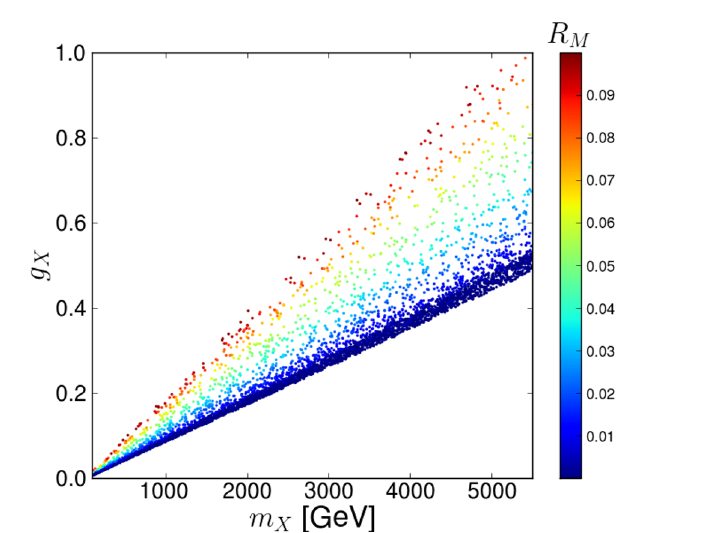
Figure 2 . The parameter points which realize relic density of DM as 0 . 11 ≤ Ω h 2 ≤ 0 . 13 ; we fix χ = 10 − 3 here. The color gradient indicates the value of R M